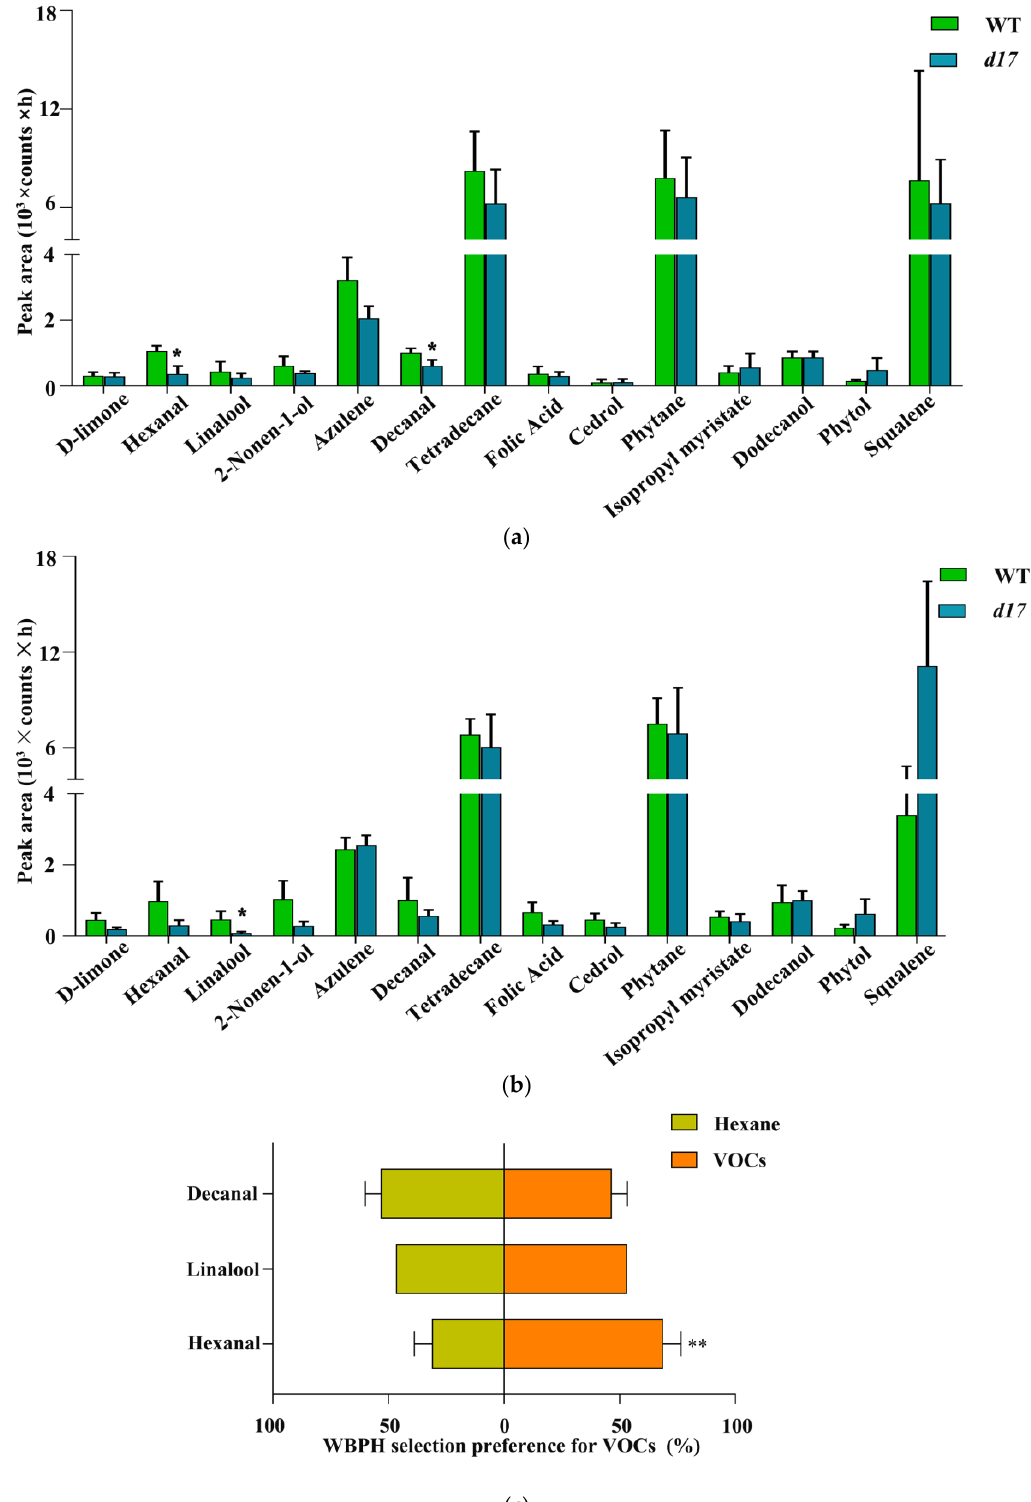
Figure 3. ( a , b ) Volatile organic compounds (VOCs) emitted from the WT and d17 plants at 30 d and 45 d. Average ( ± SD) values from three biological replicates. Significant differences were determined using Student’s t -test for dependent samples, * p < 0.05. ( c ) Olfactory response of WBPHs to VOCs in the Y-tube olfactometer. Average ( ± SD) values from three biological replicates. Significant differences were determined using the chi-squared test for dependent samples, ** p <